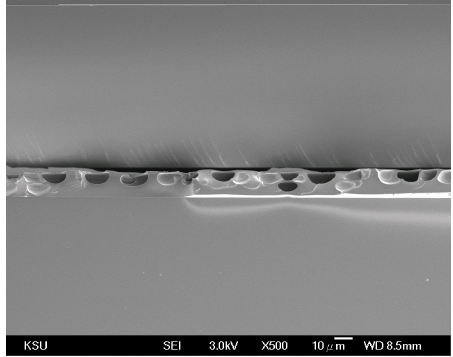
Figure 4. Side-view SEM image of the PDLC film with large droplets after removing the LCs in the droplets. Dome-like morphology with the bottom parallel to the cell substrates for the LC droplets can be clearly observed in the film.